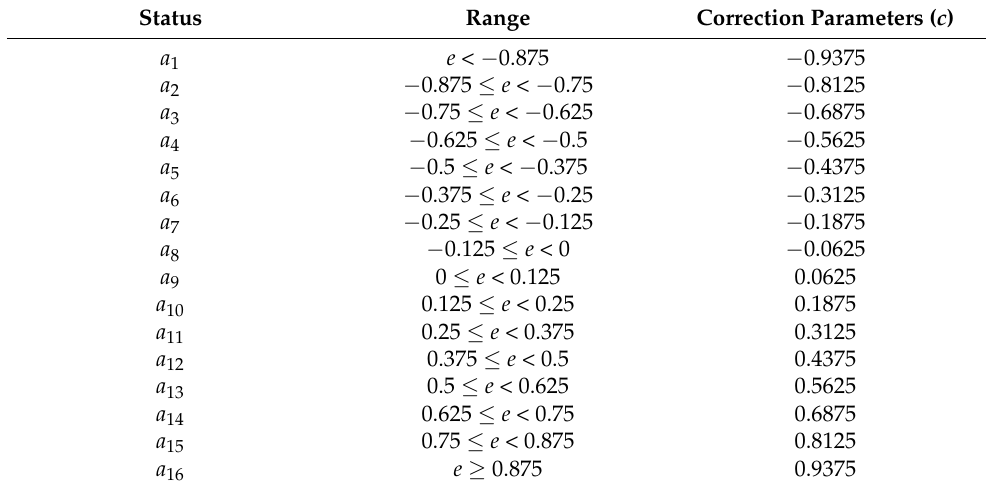
Figure 5. Estimation error distribution. Table 4. Status classification of estimation